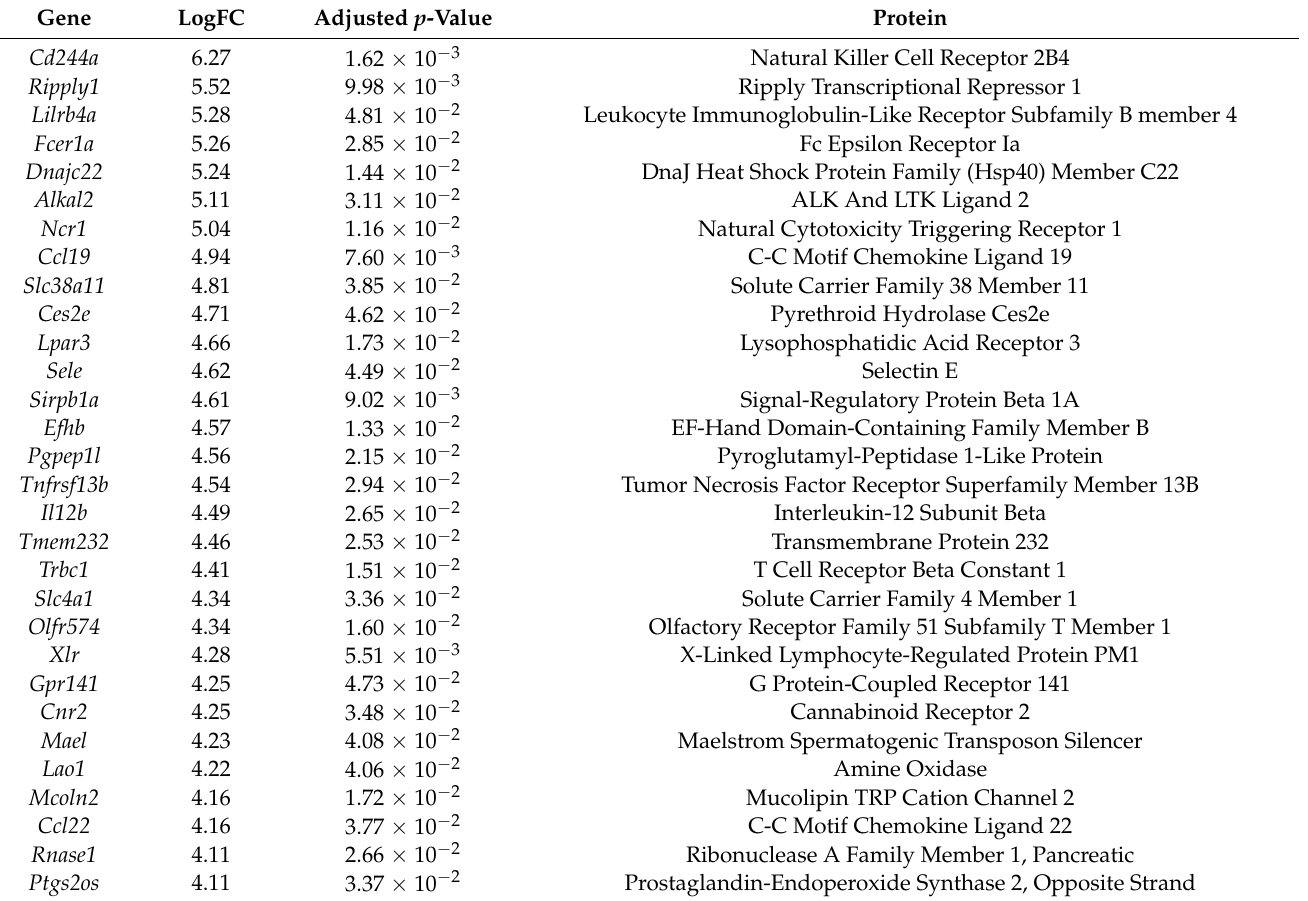
Table 1. Top 30 differentially expressed genes upregulated by high-fat diet